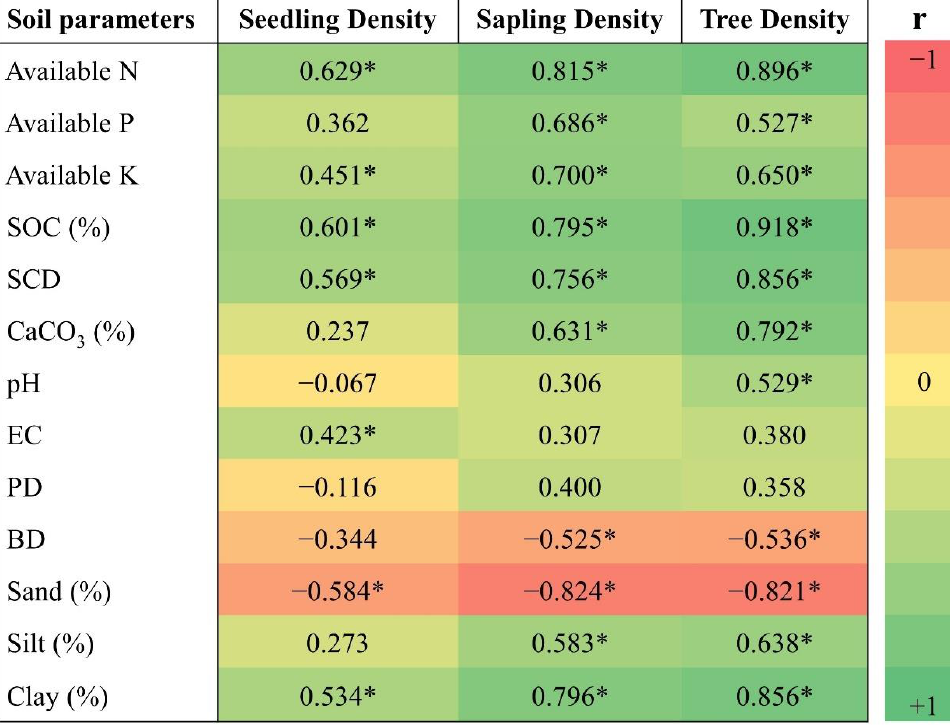
Figure 5. Simple correlations between seedling/sapling/tree abundance of J. macropoda with physico- chemical characteristics in north-western Himalayas. * Significant at 5% level of significance. SOC—